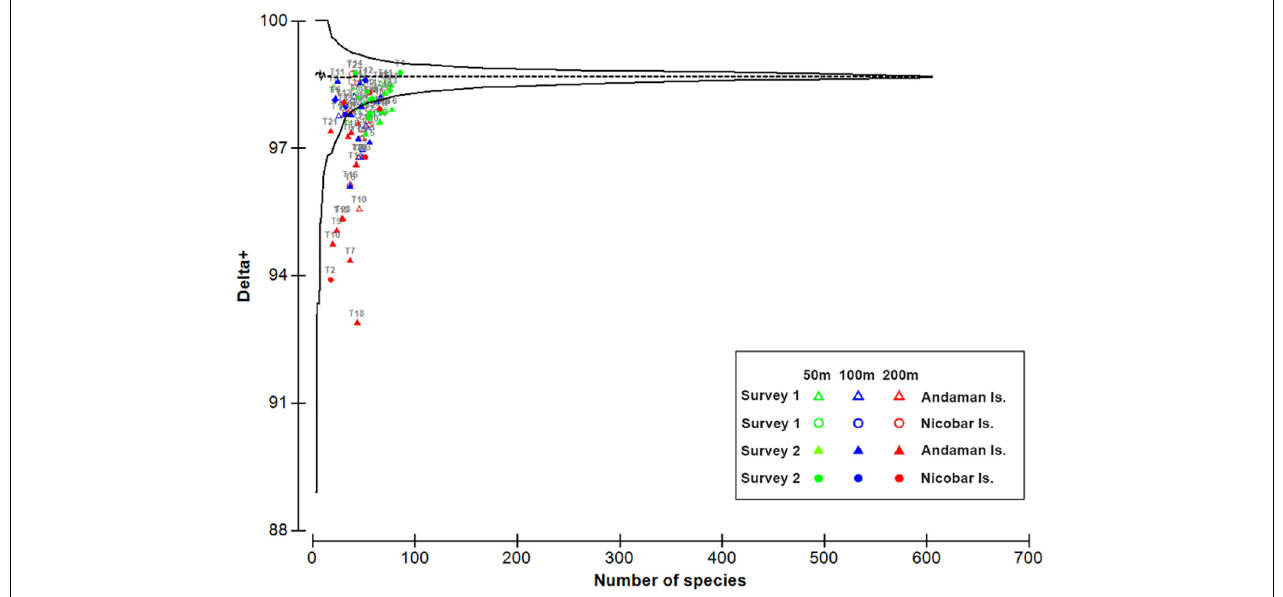
FIGURE 8 | Taxonomic funnel plot depicting number of polychaete species ( x axis) against the taxonomic distinctness index ( (cid:49) +) ( y axis), with 95% probability funnel based on the master taxonomic tree in each site at 50 m (green), 100 m (blue), and 200 m (red) depth strata in survey 1 (hollow symbols) and survey 2 (filled